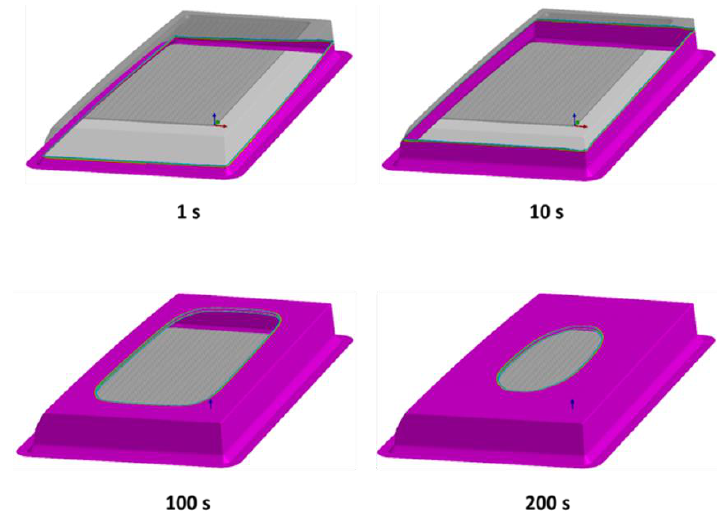
Figure 5. Visualization of the flow front calculated by the numerical model.